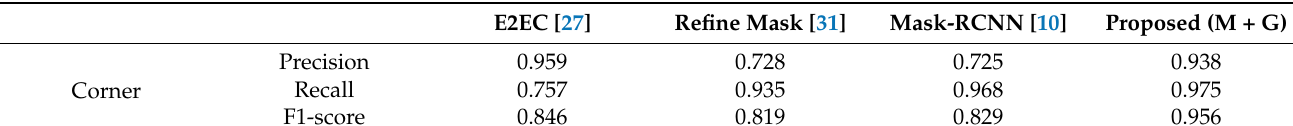
Figure 8. Qualitative comparisons against E2EC, RefineMask, and Mask-RCNN.